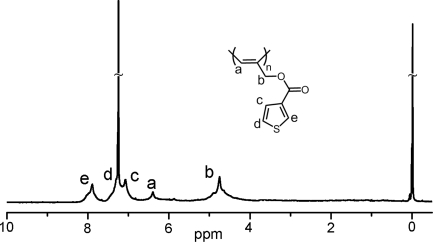
1H NMR spectrum of polymer PAT-2.